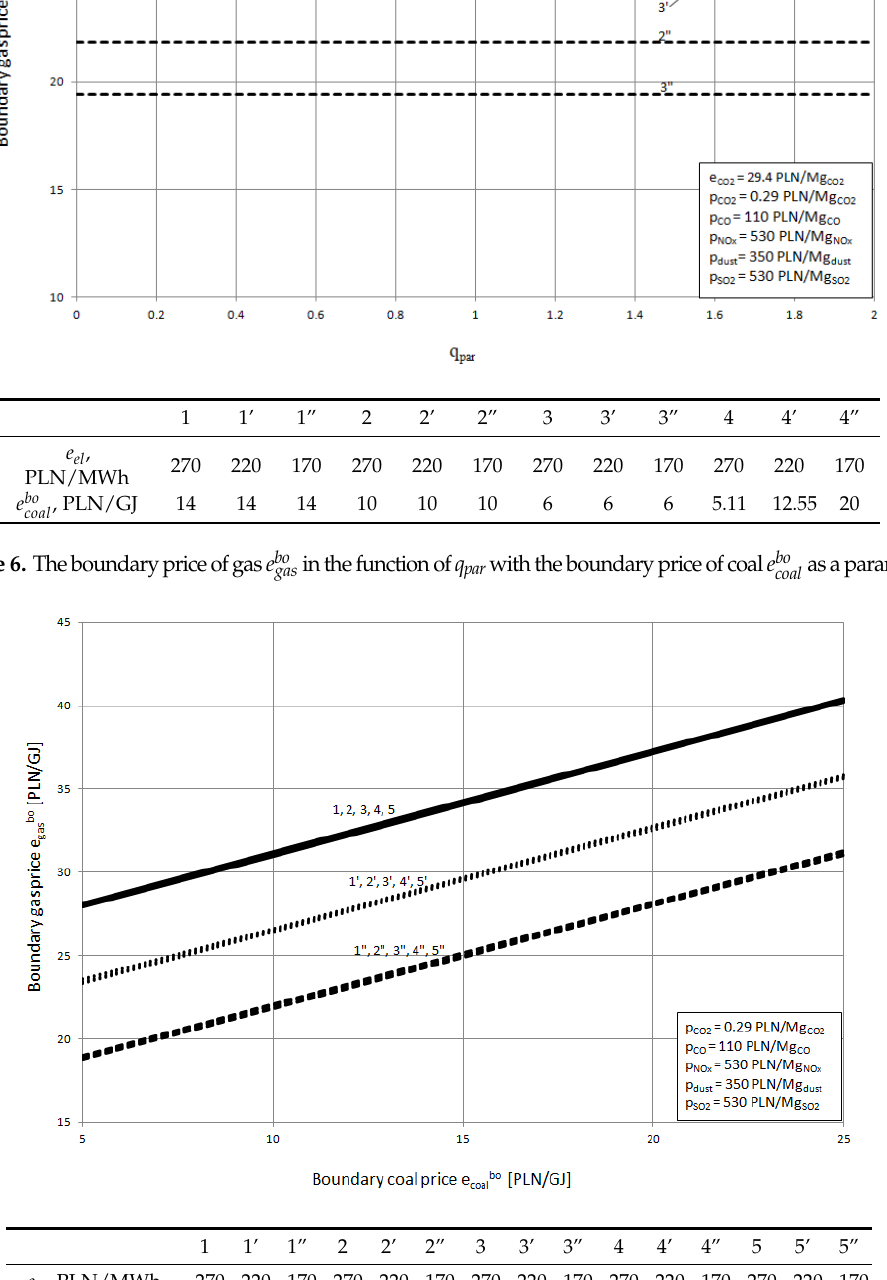
Figure 7. The boundary price of gas bo